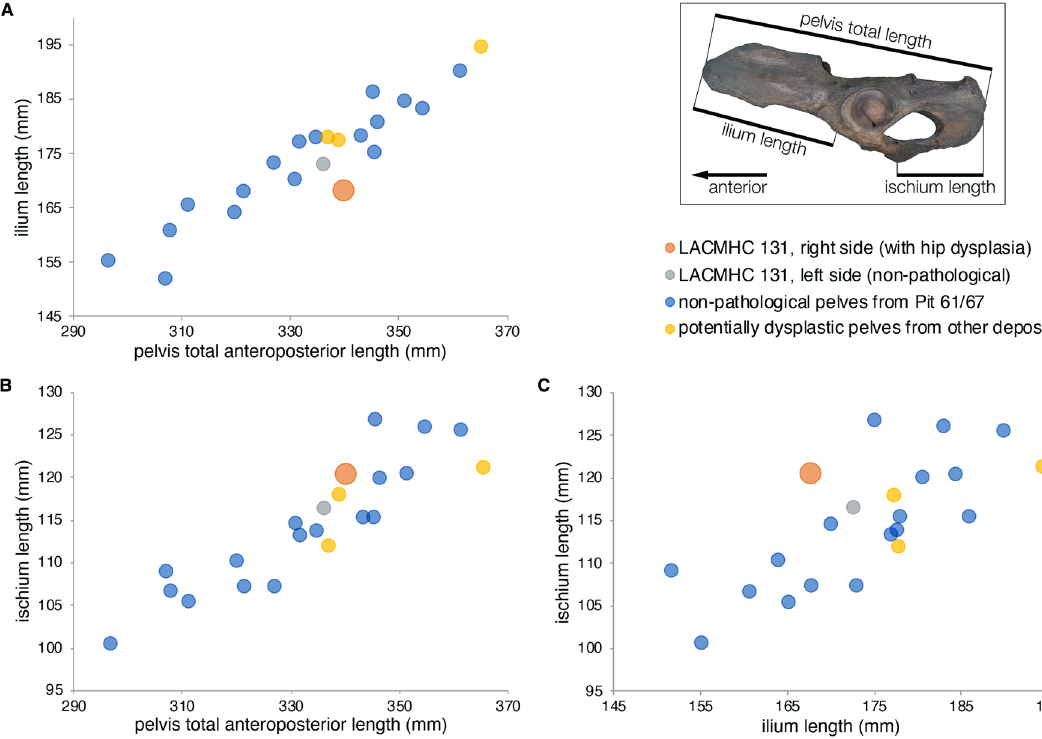
Figure 6. Metric data for the pathological Smilodon pelvis (LACMHC 131) in comparison to non-pathological specimens also from Pit 61/67 and potentially dysplastic pelvis specimens from other deposits. Inset diagram illustrates lengths measured. Across all measurements, the pathological pelvis lies well within the size range of non-pathological adult Smilodon pelves, suggesting that the animal to which it belonged also had grown to adult age. Numeric values are in Supplementary Data S4. ( A ) Bivariate plot showing ilium length (from the anterior- most point of the pelvis to the anterior border of the acetabulum) against total anteroposterior pelvis length. ( B ) Bivariate plot showing ischium length (from the posterior-most point of the pelvis to the posterior border of the acetabulum) against total anteroposterior pelvis length. ( C ) Bivariate plot showing ischium length against ilium length.